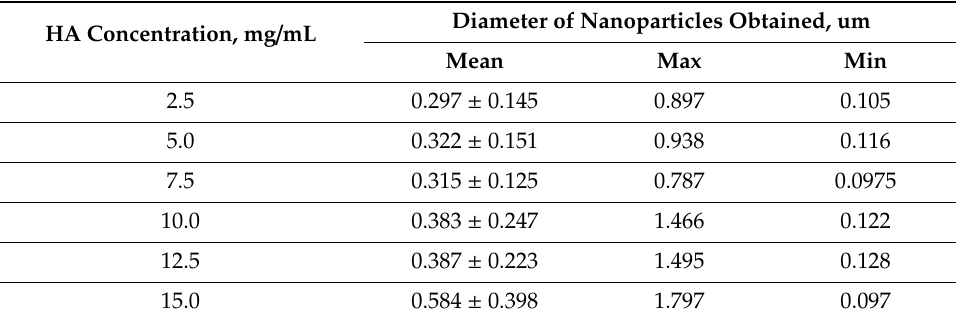
Table 2. Diameter distribution of nanoparticles obtained from hyaluronic acid